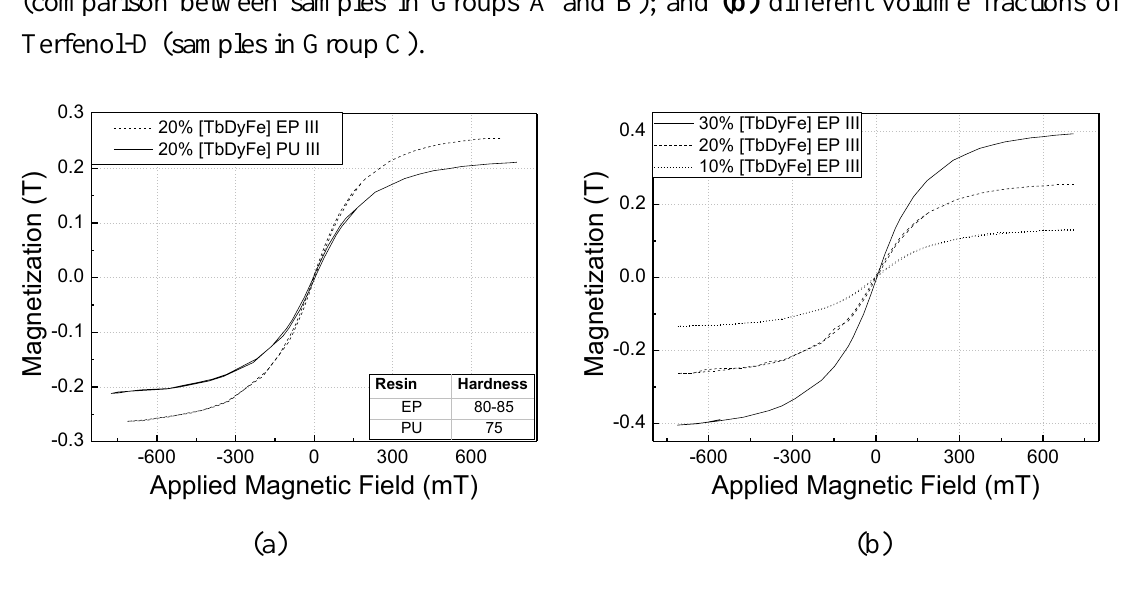
Figure 2. Magnetization of magnetostrictive composites with different particle